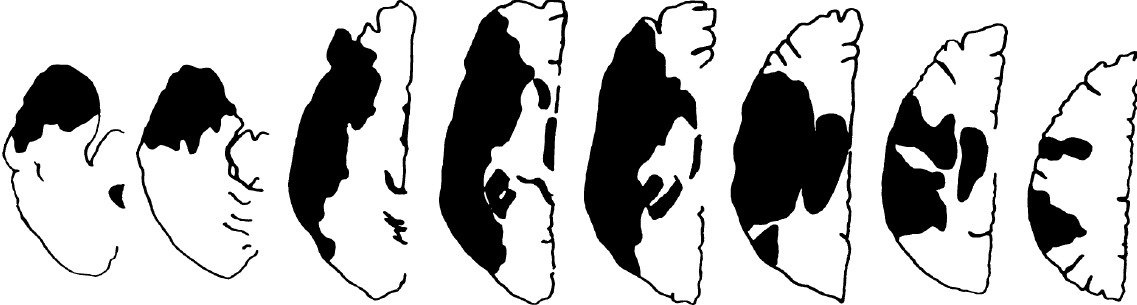
Fig. 2. Extent of the right-hemisphere lesion plotted on axial templates obtained from a CT-scan performed 1 month after onset. Section shows a large lesion in the right hemisphere, centred around the temporo-parieto-occipital carrefour, respecting the thalamic region and encroaching upon the external capsule and the